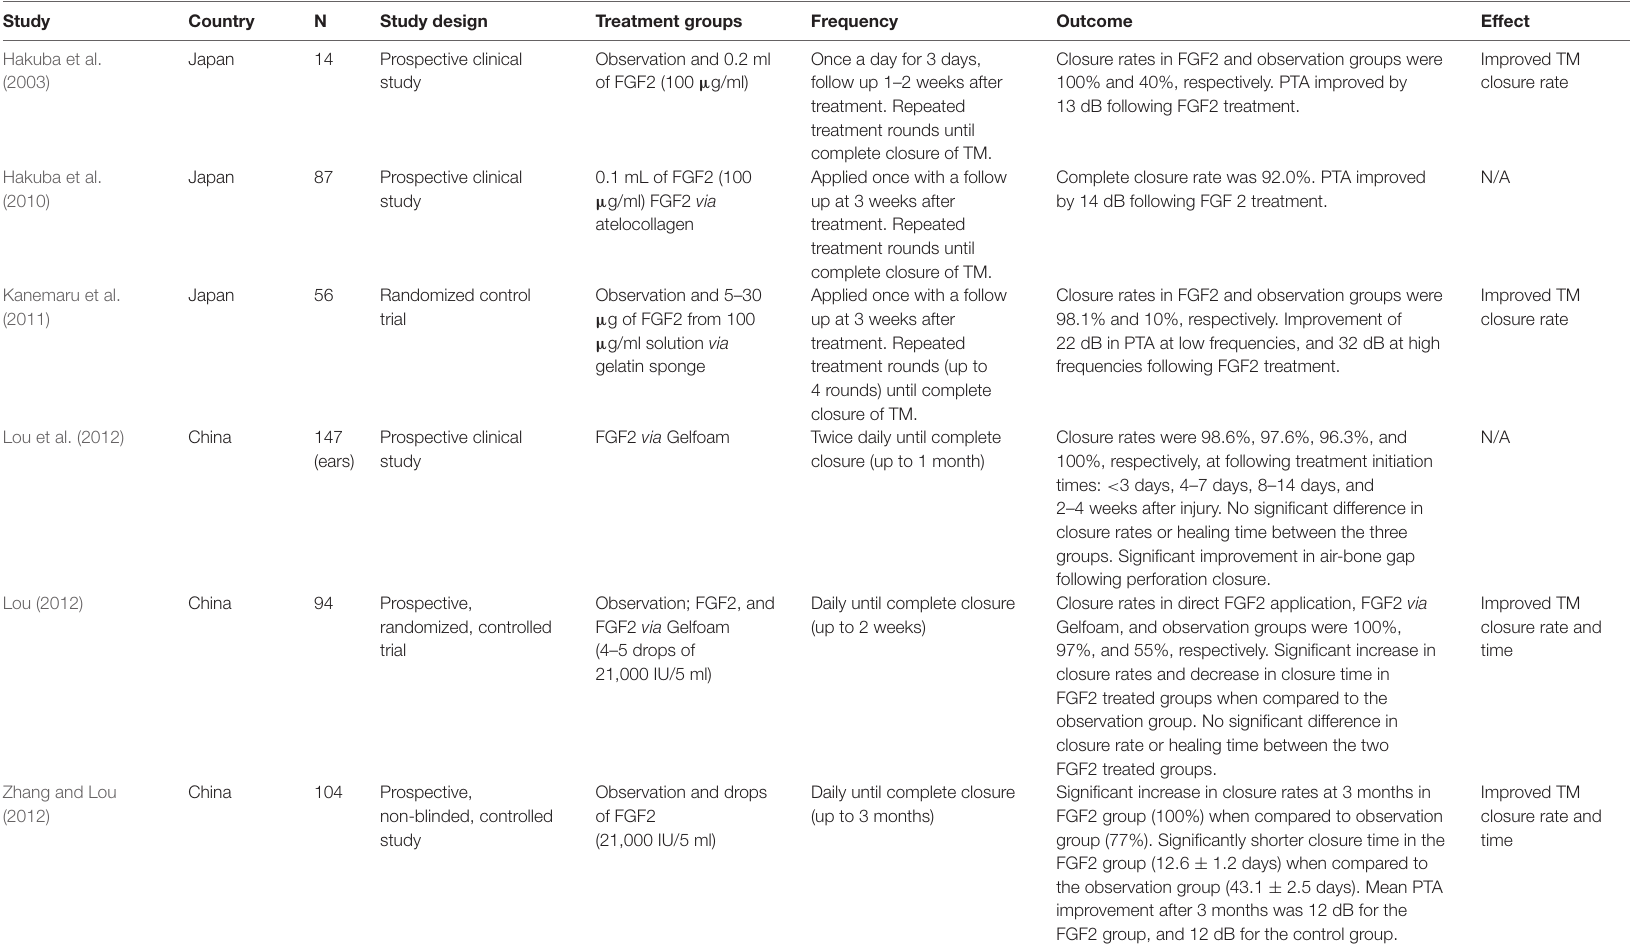
TABLE 4 | Clinical studies of FGF2 in tympanic membrane